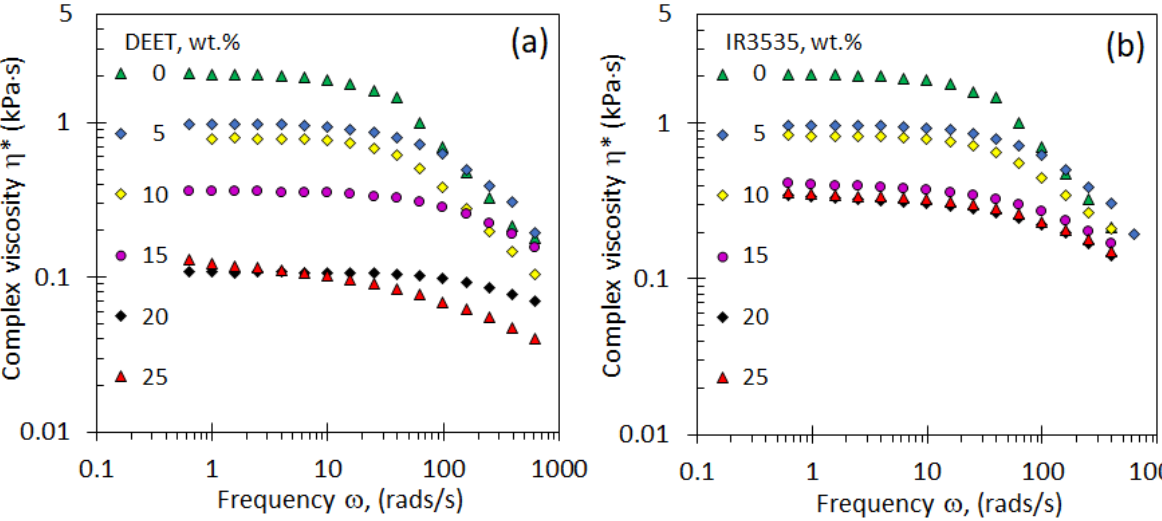
Figure 5. Complex viscosity vs . versus angular frequency curves measured at 200 ° C. The effect of repellent concentration is shown in ( a ) for PLA/DEET blends, and in ( b ) PLA/IR3535 blends.